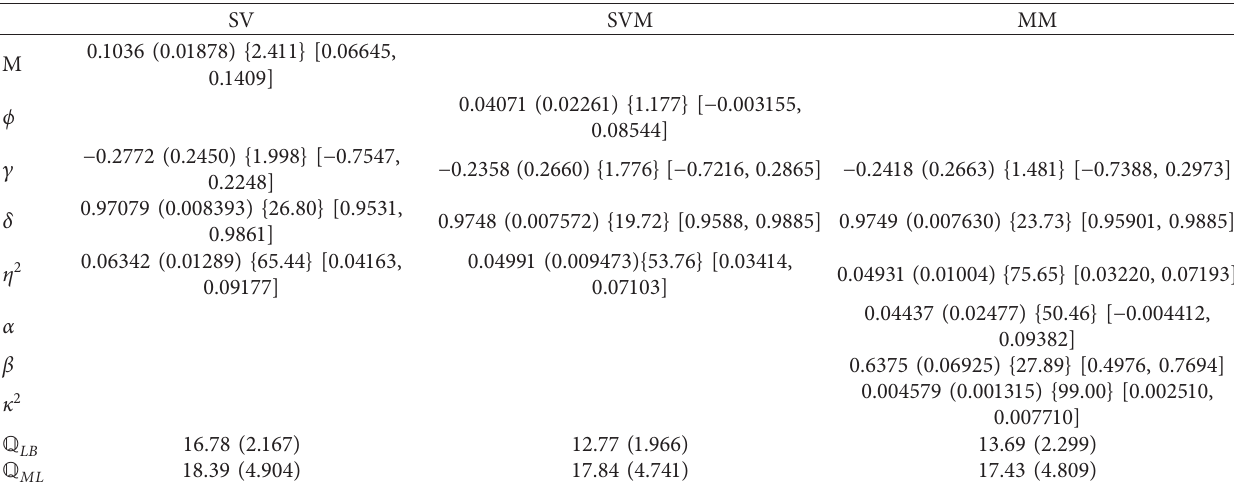
Table 4: Parameter posterior means, standard deviations (in parentheses), inefficiency factors (in braces), and 95% intervals (in square brackets) for the stochastic volatility models by using the precision-based simulation smoother